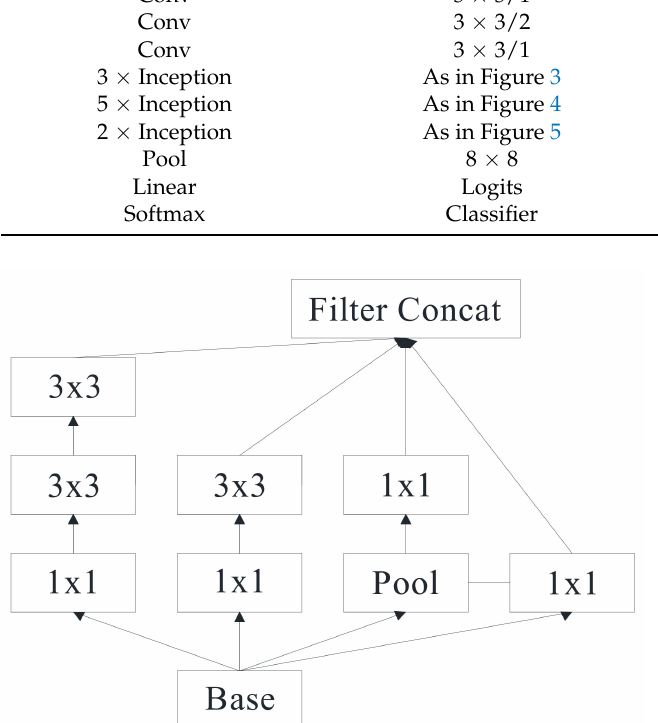
Figure 3. The 3 × Inception module.